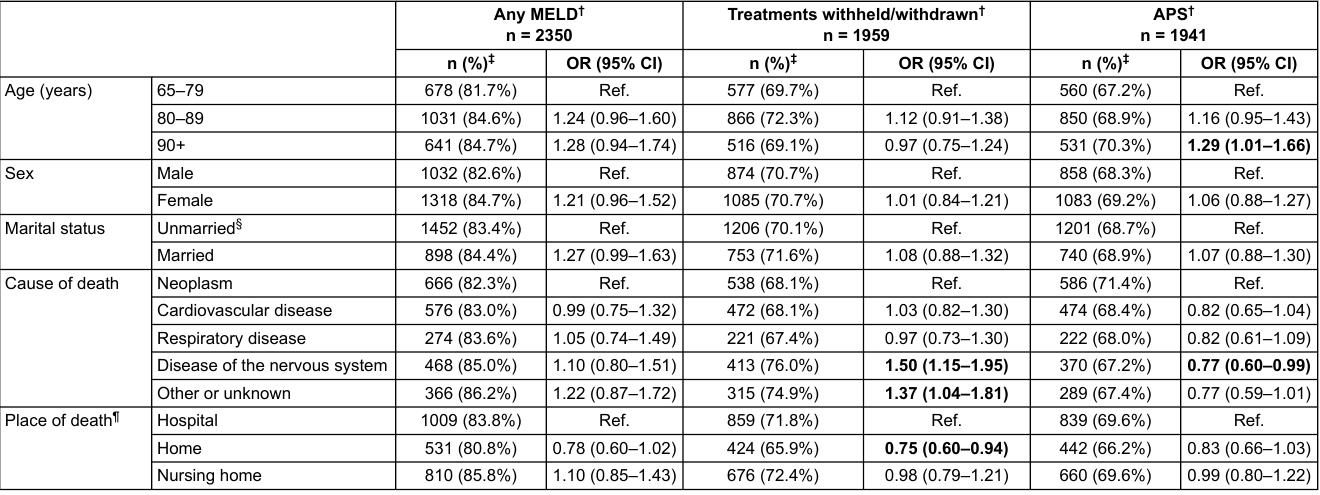
Table 2: Age and other determinants of medical end-of-life decisions * : multi-variable logistic regression (n = 2842).